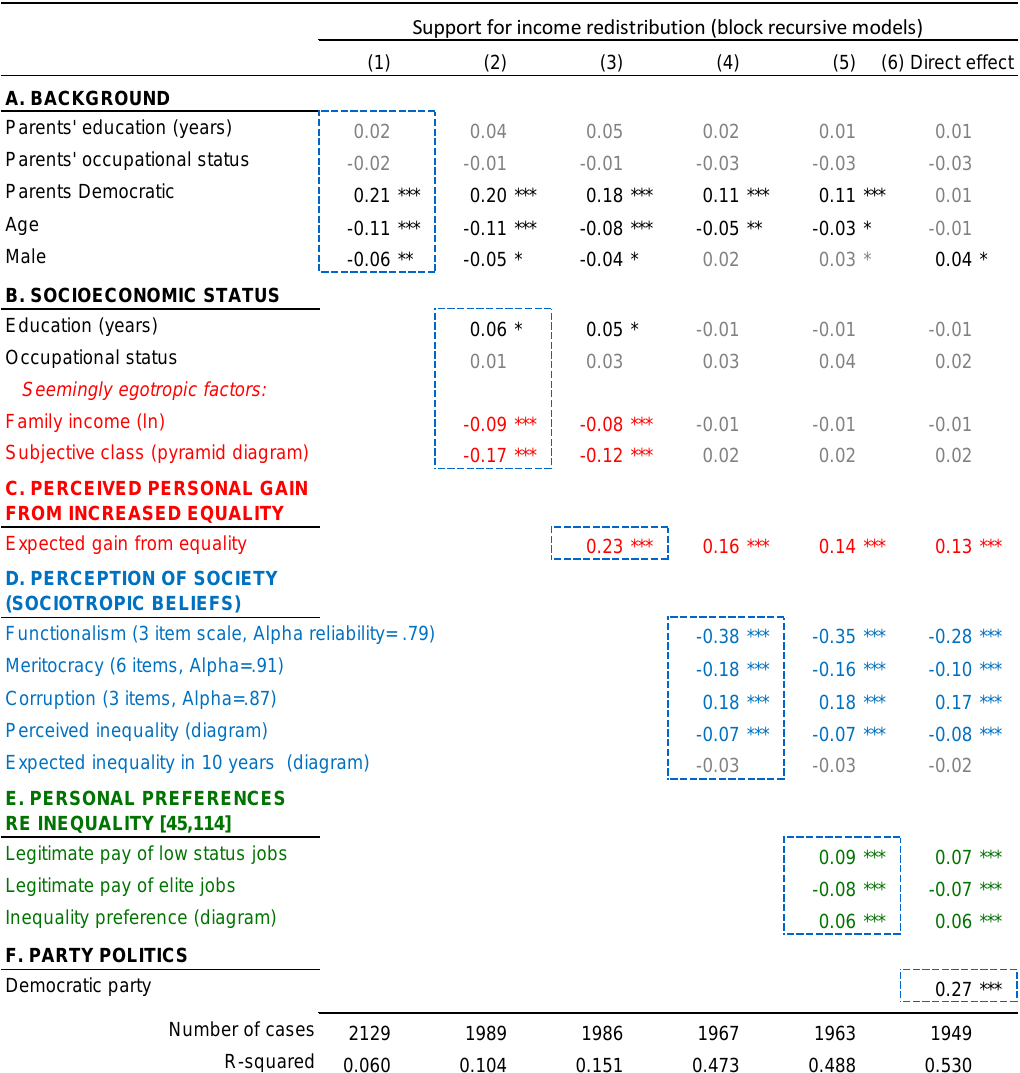
Figure 18. Effect of family income on support for income redistribution (points out of 100). OLS regression estimates separately for each nation, controlling for gender, date of birth, and education. Number of cases shown in the previous figure. Nations ordered by language and welfarism.